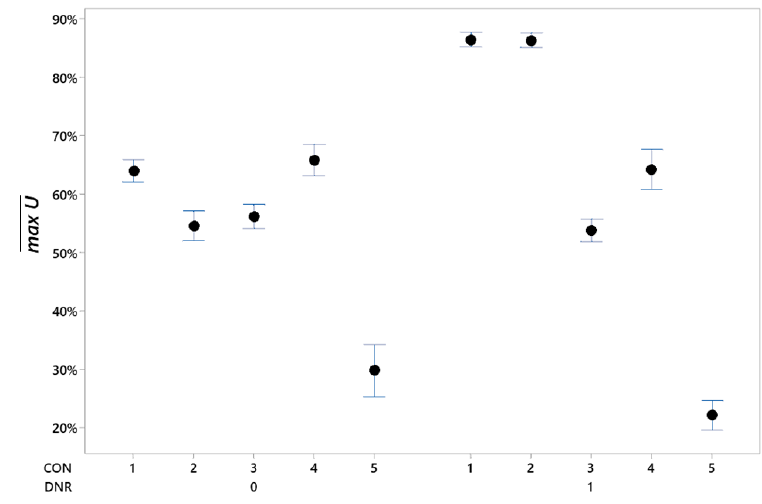
Figure 4. Confidence intervals for maximum unmet demand (α = 0.05).